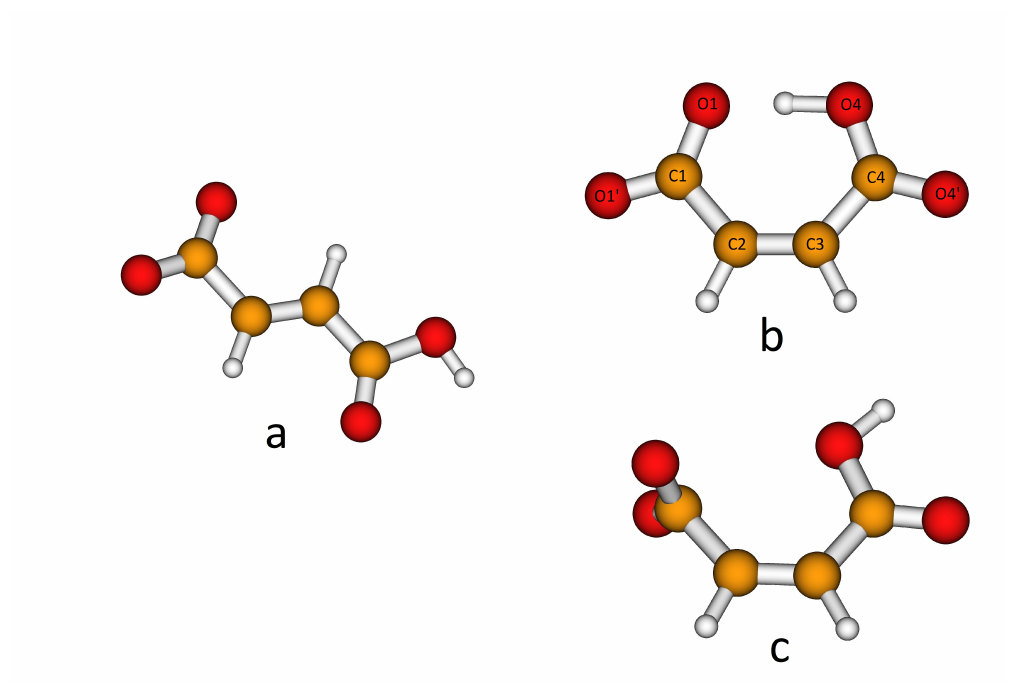
Figure 1. Equilibrium structures of the H-fumarate ( a ) and H-maleate ( b ) anions and open structure of the H-maleate anion ( c